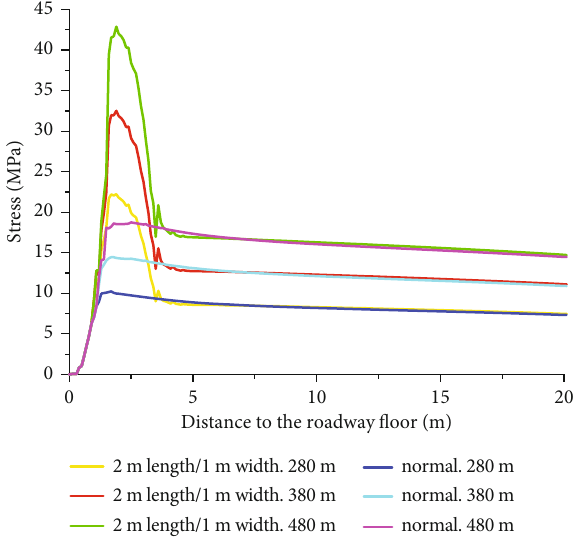
Figure 6: Horizontal stresses below the roadway fl oor at di ff erent burial depths.